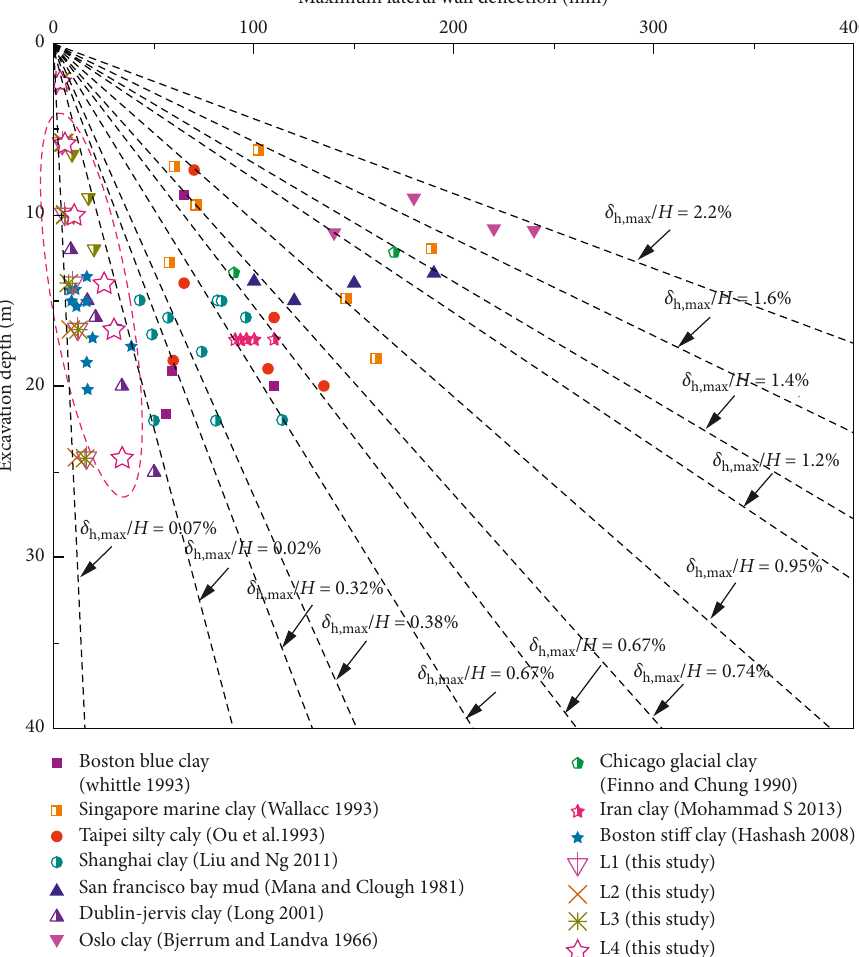
Figure 13: Maximum lateral wall deflections versus excavation